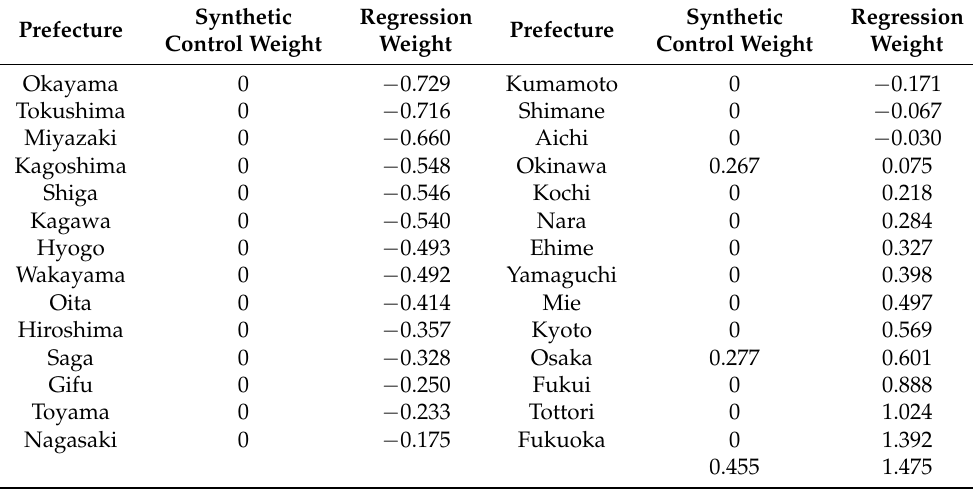
Table 1. Synthetic control and regression weights for Tokyo.